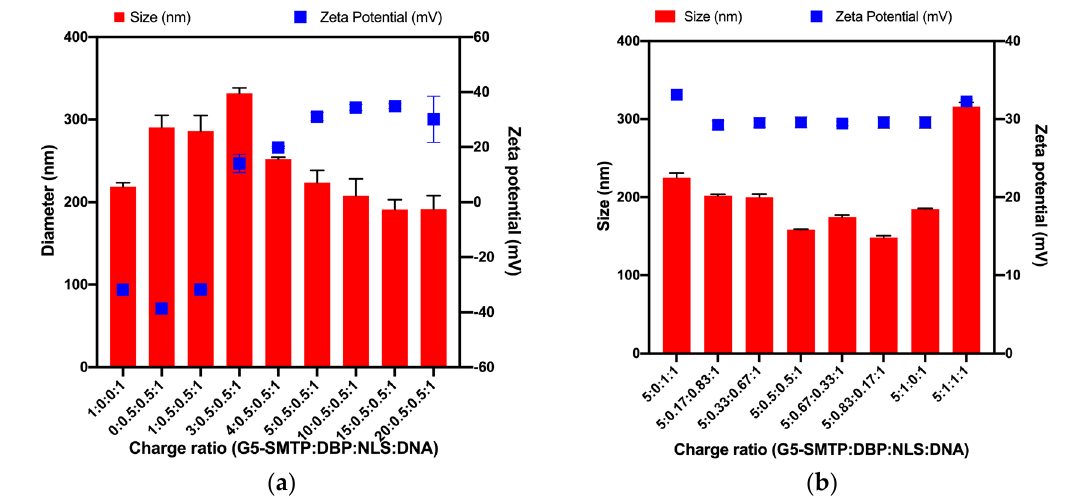
Figure 3. Dynamic light scattering and Zetasizer analysis of the polyplexes (G5-PAMAM–SMTP:DBP:NLS:pµDys). ( a ) Variations in size and surface charge with changes in the amount of the dendrimer. ( b ) Variations in size and surface charge with changes in the ratio of the DBP and NLS peptides while keeping the dendrimer/pµDys ratio constant at 5:1.